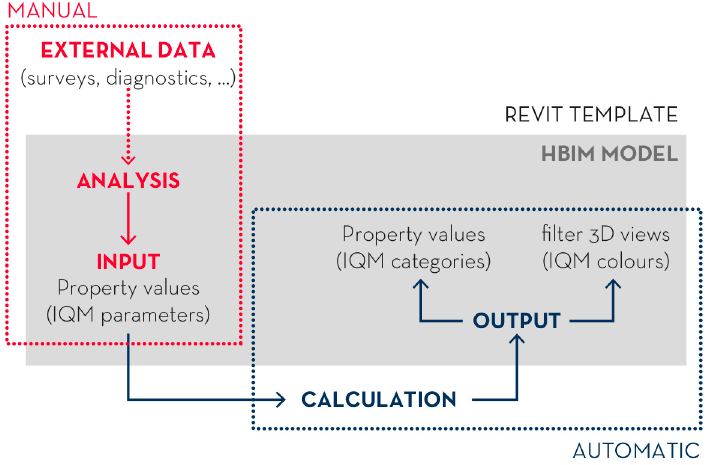
Figure 11. Schematic representation of the double nature of the process: on the one hand, the modelling and assessment phases, carried out by an IQM operator within the IQM Revit template, and the IQM calculation and results, automatically provided by the VPL code within the same template.